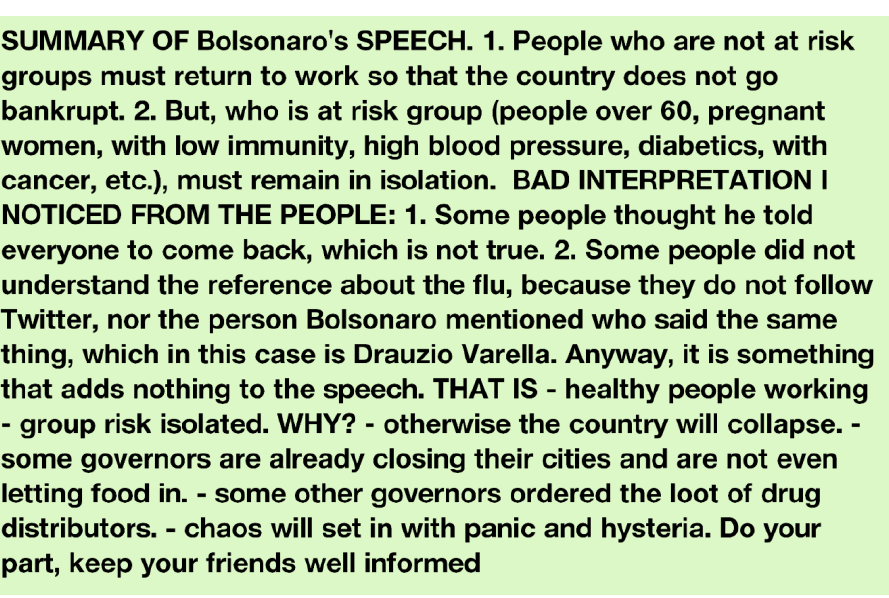
Figure 7. Distorting message about social